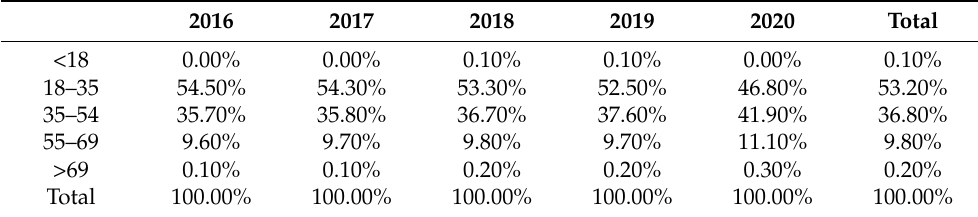
Table A1. Distribution of age groups versus the year of measurement.